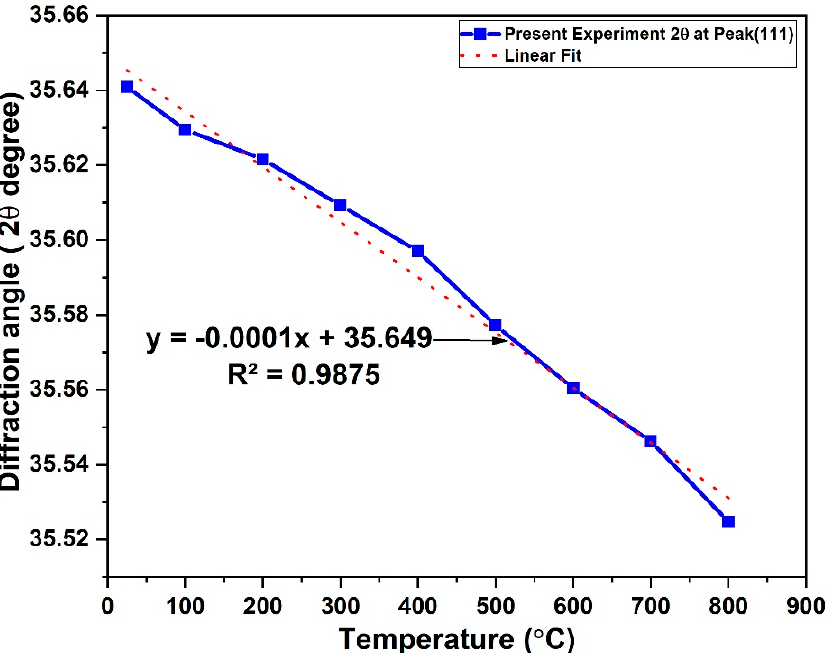
Table 2. Thermal expansion causes a nearly linear rise in the unit cell volume of beta silicon carbide over the whole temperature range investigated, as shown in Figure 6. The error bar indicated there is statistically significant change between the lattice parameter and volume as function of temperature. This trends which agree with previous works [23–27].